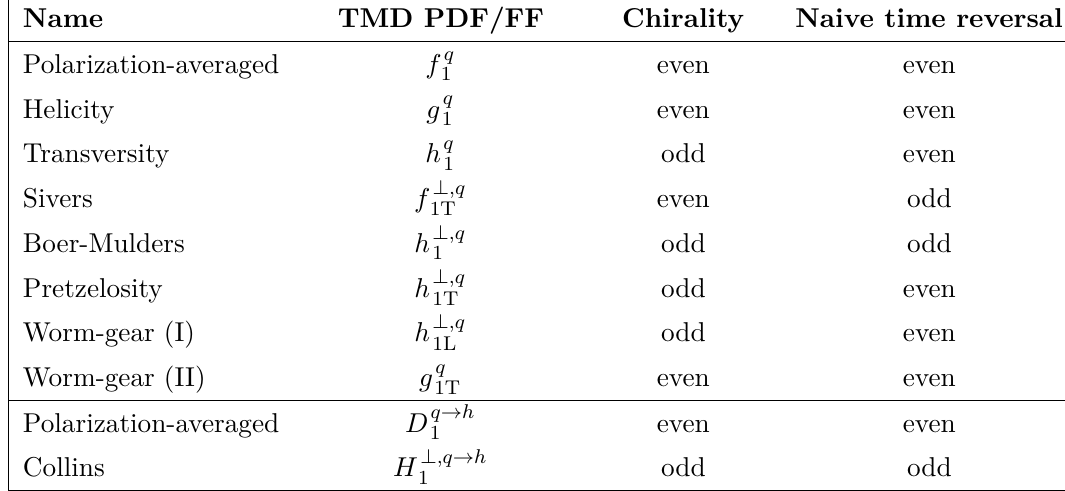
Table 1 . Leading-twist TMD distribution and fragmentation functions and their key symmetry properties. Only the first three TMD PDFs and D q → h